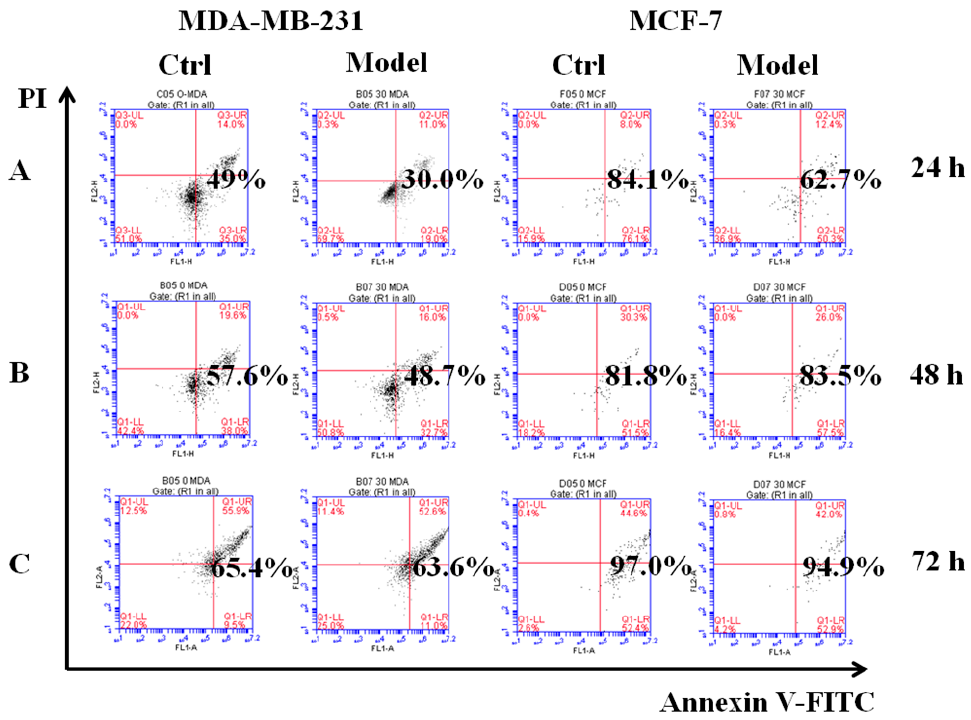
Figure 4. Simulating detached cancer cells with the ability to resist anoikis. The effects of cell apoptosis on MDA-MB-231, MCF-7 cells cultured for 24 h ( A ), 48 h ( B ), 72 h ( C ) in six-well cell culture plates treated with poly-HEMA (30 mg/mL), respectively. As a control, the cells were cultured in low-adhesion plate for 24, 48, 72 h, respectively.